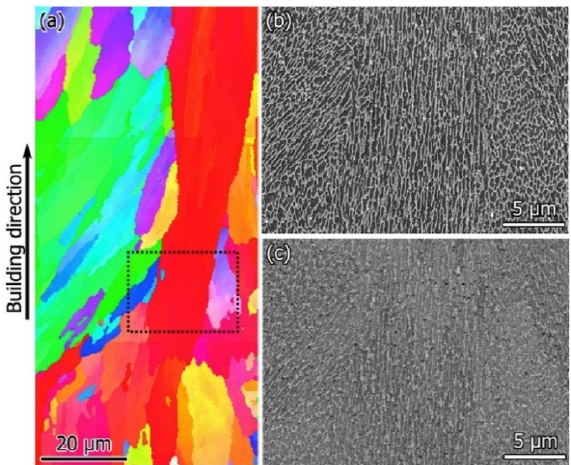
Figure 40. SEM images of AlSi10Mg SLM samples along the YZ plane: ( a ) electron back scattered diffraction, ( b ) secondary electron image and ( c ) back-scattered image. The inset in ( a ) shows the area in the electron back-scattered diffraction image, where the secondary and back-scattered images are taken [172]. Copyright 2016. Adapted with permission from Elsevier Science Ltd. under the license